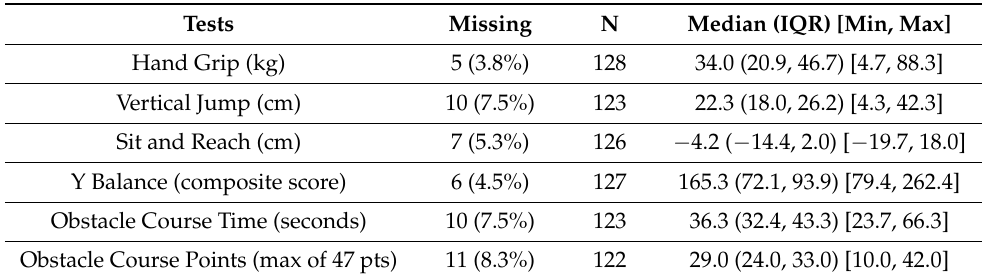
Table 2. Descriptions of Physical